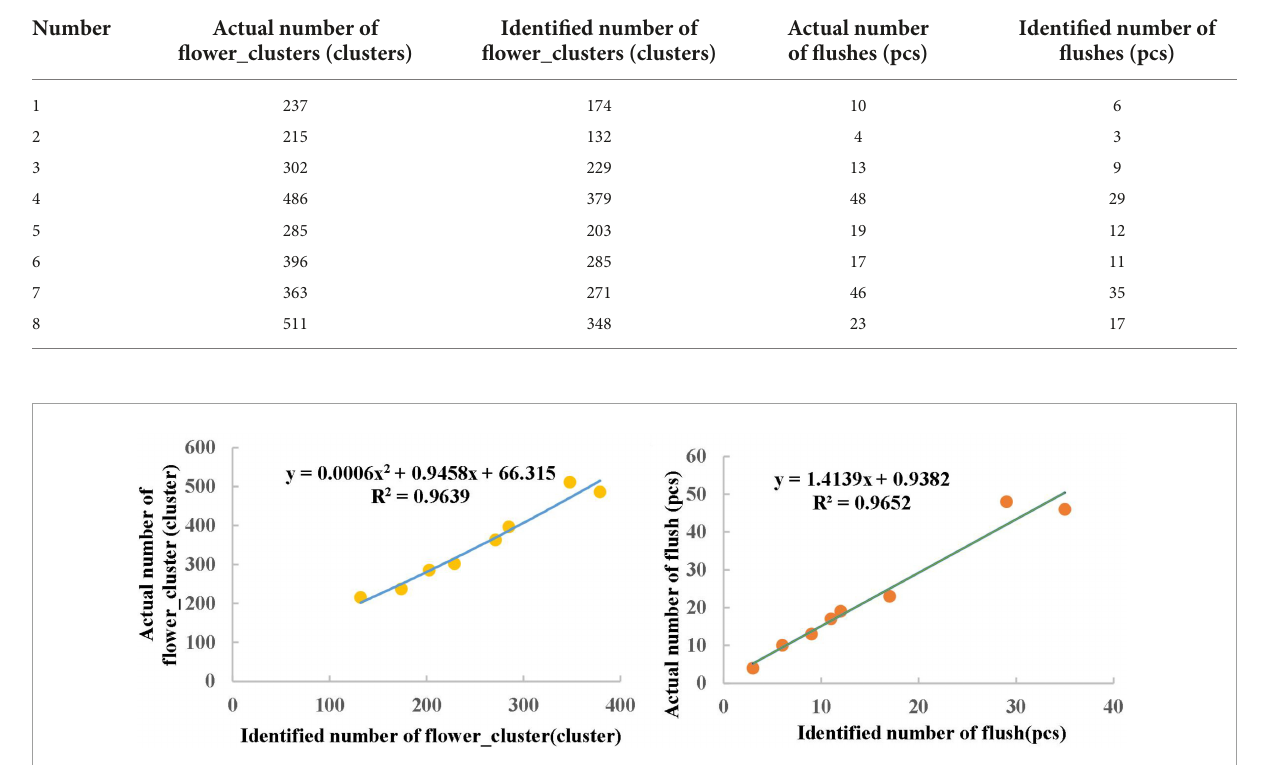
FIGURE8 Fitting results for the numbers of flower clusters and flushes on eight litchi trees.